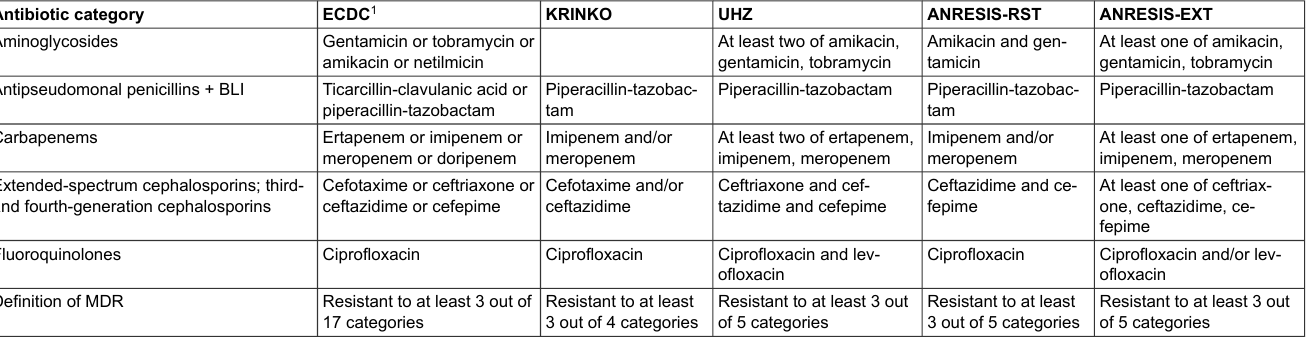
Table 1: Definition criteria and antibiotic panel for Enterobacterales.